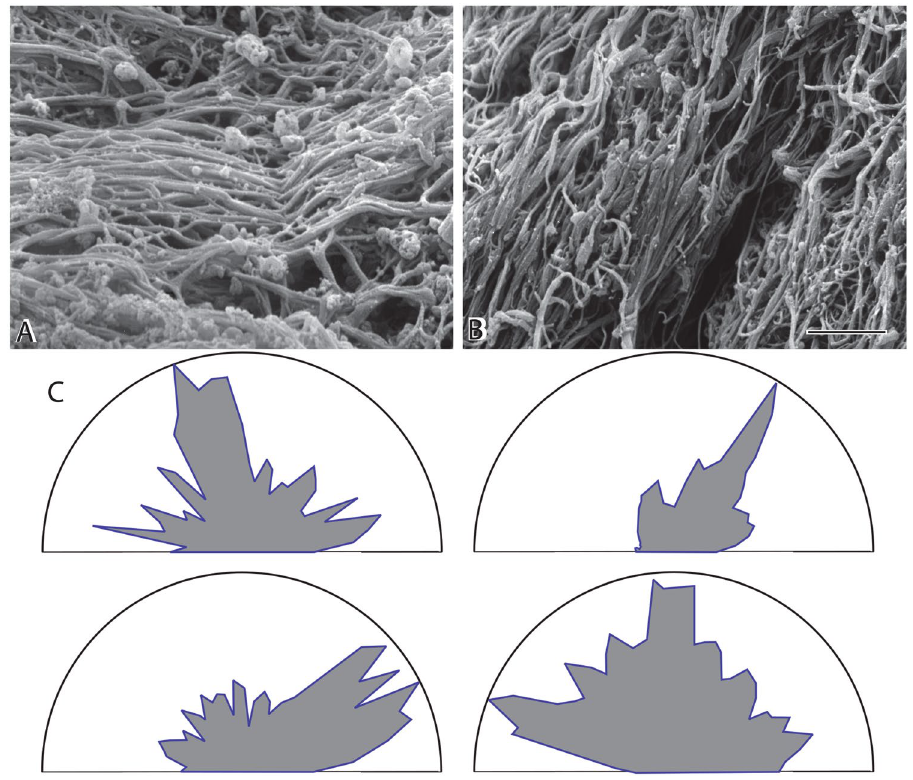
Figure 5. Orientation of fibrin fibers in thrombi. Some areas of some thrombi contained fibrin fibers largely oriented in a single direction. ( A ) Dense network of roughly horizontally oriented fibers. ( B ) Dense fibers oriented diagonally. ( C ) Polar plots of the frequency of fibers with different orientation. Distance ‘r’ represents the frequency of fibers with orientation at each angle between 0° and 180°, normalized to the maximum frequency. The angles are between 0°–180° rather than 0°–360°, because there is no directionality of the orientation. Each plot is from a single micrograph and the absolute value of the angle is arbitrary, but only relative to the other fibers in an individual image, which is why the values are not given on the coordinate for angles. Magnification bar = 1 µ